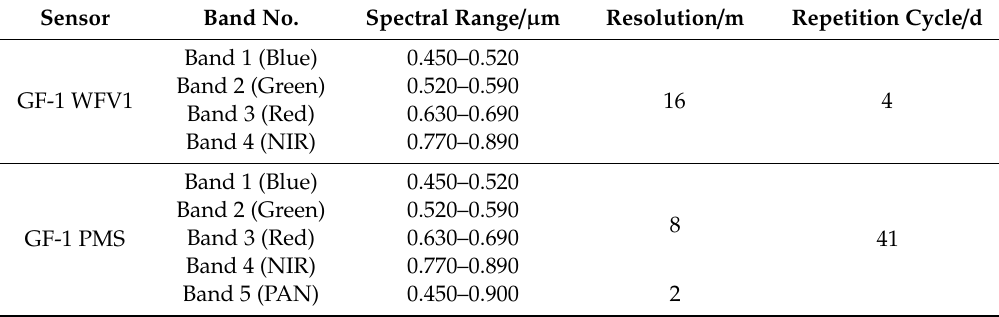
Table 1. Introduction of WFV1 and panchromatic and multispectral (PMS) sensor parameters.